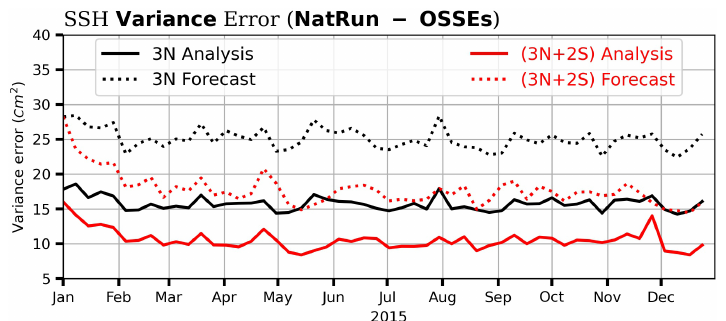
Figure 4. The temporal evolution of the SSH error variance in global ocean analysis and forecast over 2015. Results obtained by comparing the SSH ocean analysis (solid lines) and forecast (dash lines) with the SSH from the NR. Experiments with assimilation of three nadirs (3N) (black lines) and with assimilation of three nadirs and 2 swath altimeters (3N + 2S) (red